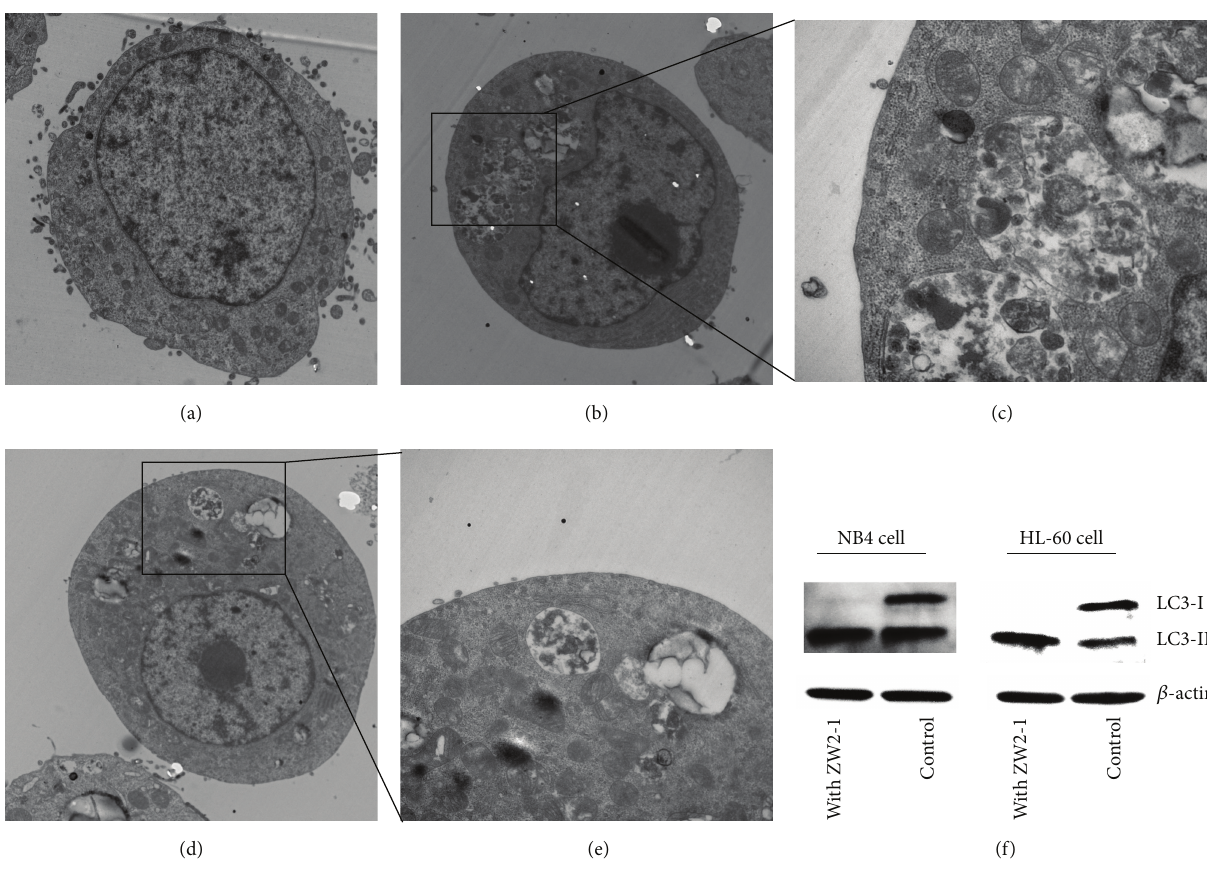
Figure 4: TEM images of HL-60 cells treated with ZW2-1 and western blots analysis of autophagy marker protein LC3. (a) Control group. (b, d) Cells were exposed to ZW2-1. (c, e) The magnification of selected area. (f) Effect of ZW2-1 on the LC3-I/LC3-II